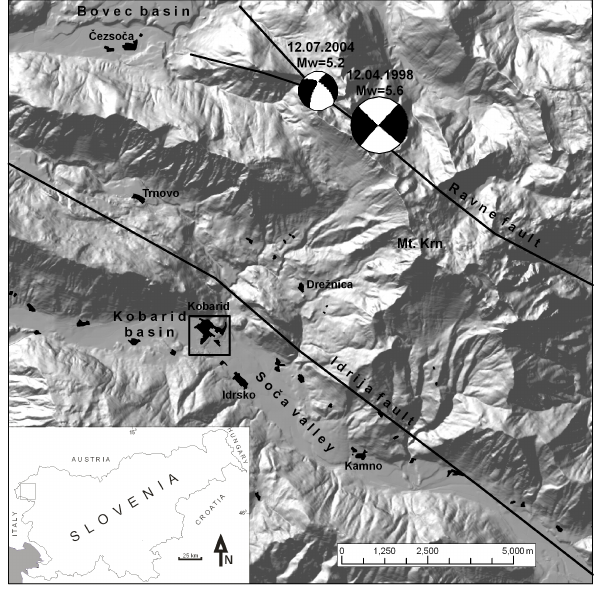
Fig. 1. Shaded relief map of the Upper Soˇca valley with the Ko- barid basin and epicentres of two recent strong earthquakes in Krn mountains. A rectangle indicates study area shown in Figs. 2, 6 and